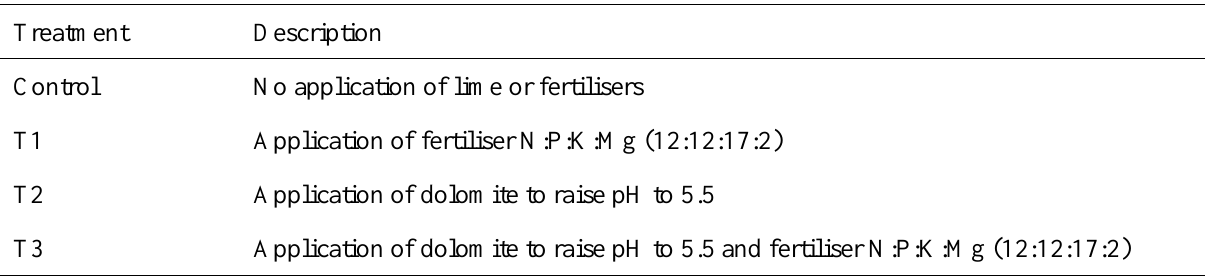
Table 1. Treatments applied to the hemic and sapric peat materials.